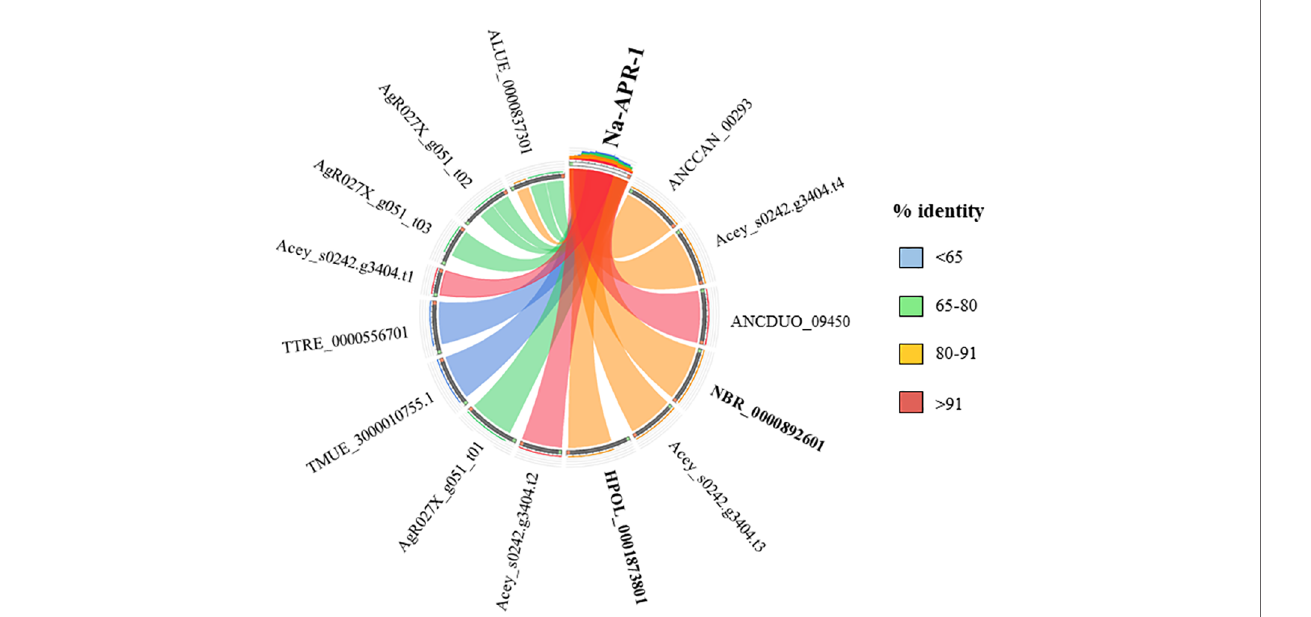
FIGURE 4 | Similarity plot. Circos plot generated using Circoletto (Darzentas, 2010) showing the percentage of identity between Na-APR-1 and their homologues in different rodent model nematodes. Only homologues with e-values < 1E-50 are shown. Protein names as per Parasite WormBase database (v.15) have been used for comparison. ALUE, Ascaris lumbricoides ; AgR, Ascaris suum ; ANCCAN, Ancylostoma caninum ; Acey, Ancylostoma ceylanicum ; ANCDUO, Ancylostoma duodenale ; HPOL, Heligmosomoides polygyrus ; NBR, Nippostrongylus brasiliensis ; TMUE, Trichuris muris ; TTRE, Trichuris trichiura